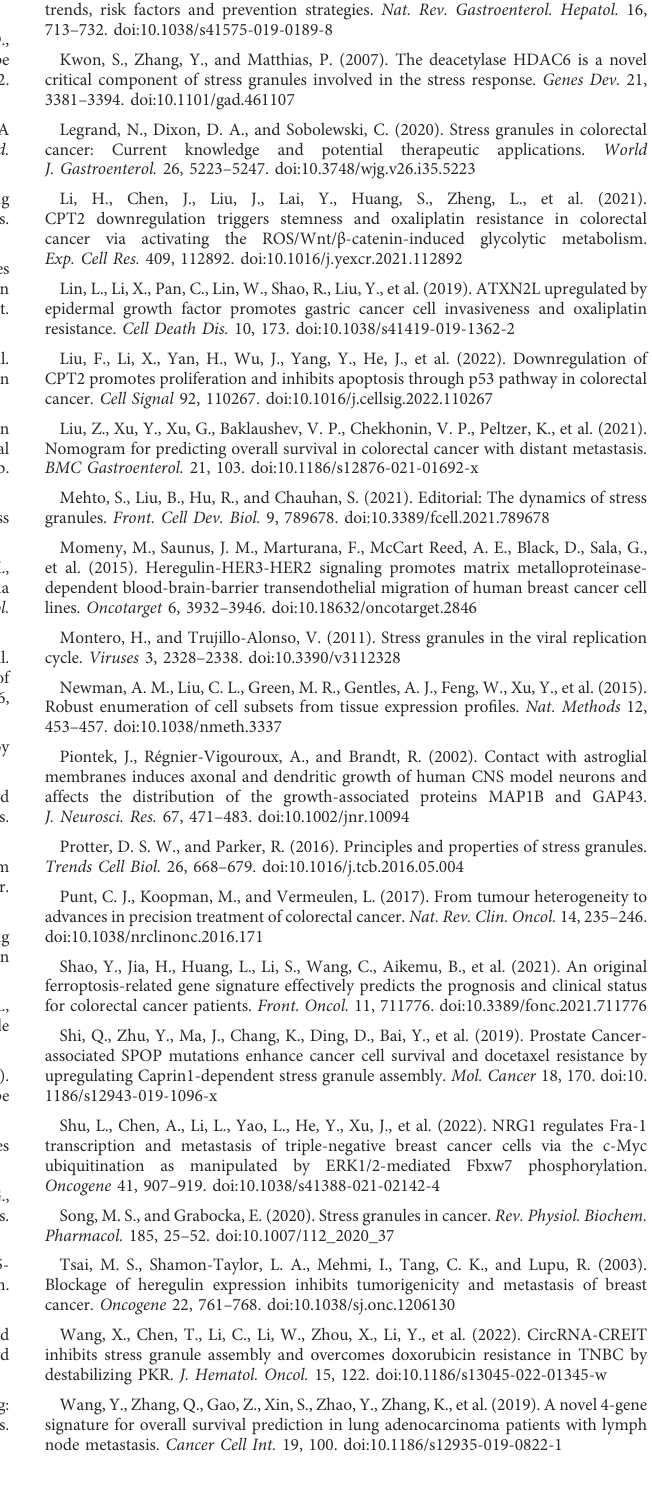
samples. (C) The heatmap showed the expression of four signature genes between tissues from tumors and normal tissues across the entire TCGA cohort. (D,E) ROCcurveandsurvivalanalysisinGSE17536datasetfromGEO